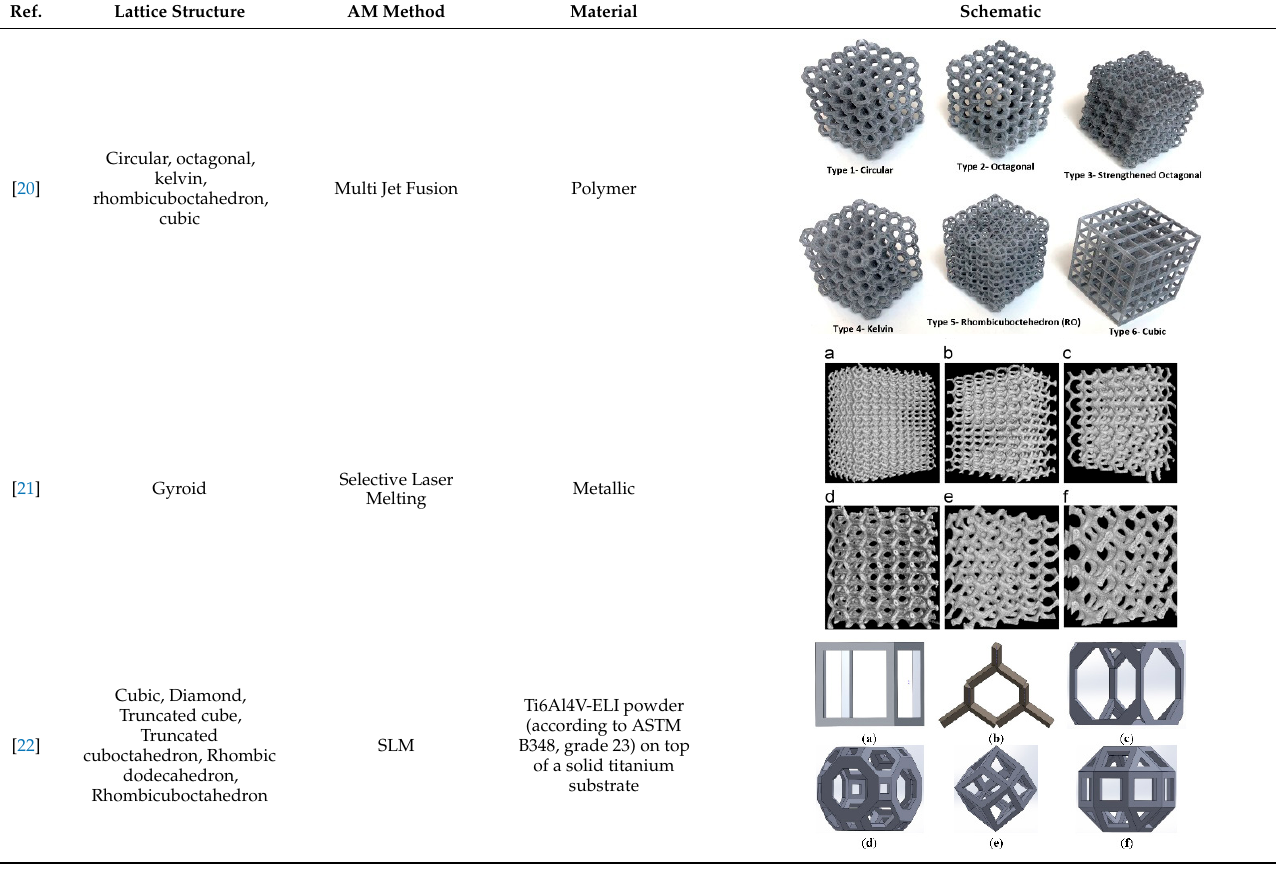
Table 1. The investigated lattice structures, materials, and additive manufacturing methods. Ref.